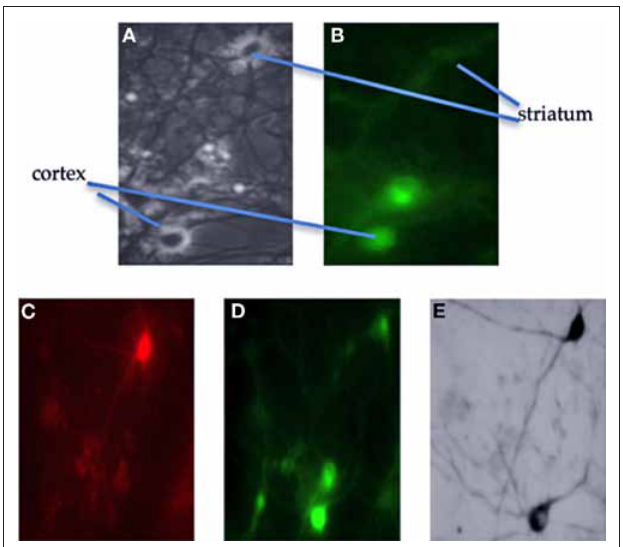
Figure 1 | identification of anatomically connected neurons. Cortical neurons were prepared from a transgenic mouse labeled with green fluorescent protein (GFP). (A) Phase contrast image of the field from which neurons were selected. The recorded neurons are indicated in this photograph and in (B) which is a fluorescence image of the same field. After the recording; (C) shows the same field as B but this time with filters to show the red fluorescent dye in the striatal neuron. (D) Now the lower cortical neuron is filled with green dye. (e) Shows the neurons after fixation and re-staining for the biocytin also present in the recording electrodes; now both neurons are black.